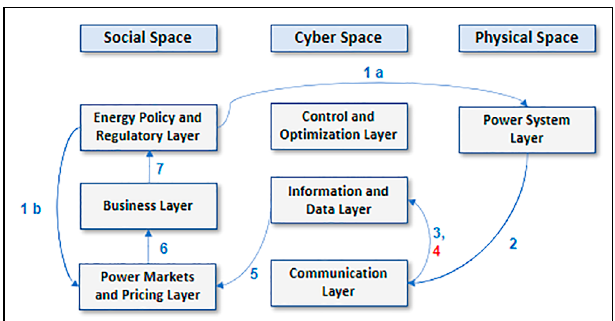
FIGURE 1 | Energy CPSS Interactions of the